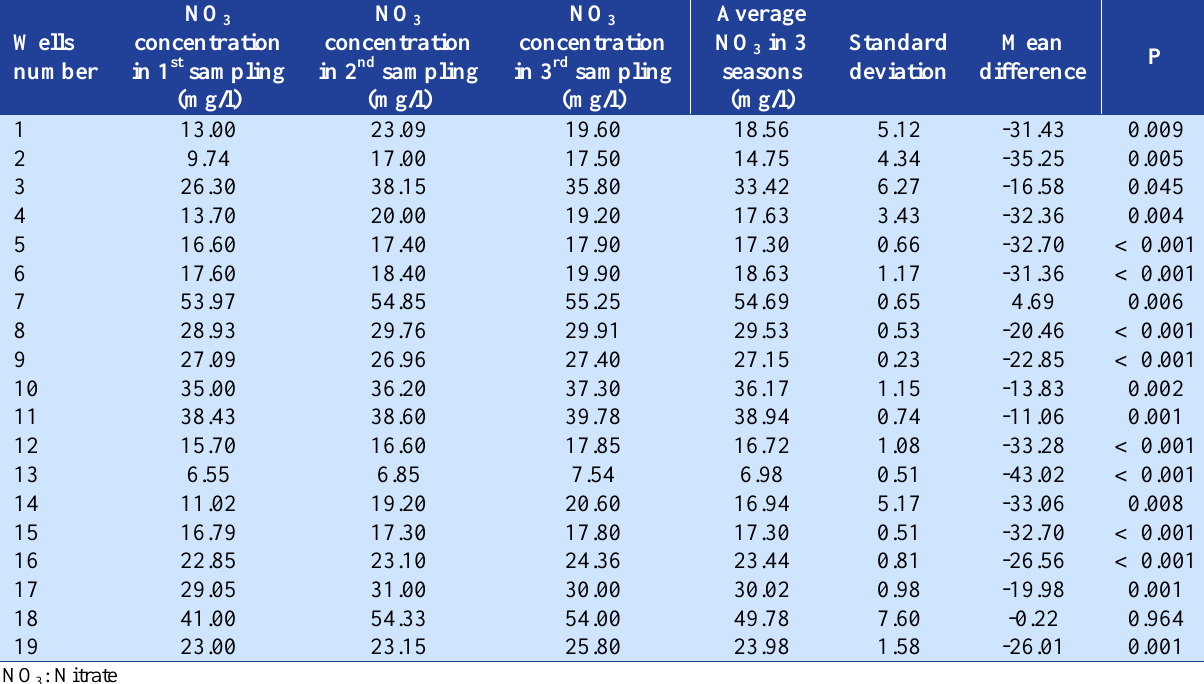
ArcGis software in the Geo Tiff format. In the ArcGis software, we turned off all layers except the vegetation layer. Figure 4 is the final image produced from vegetation area in the ArcGis software. According to the extracted maps using remote sensing techniques, the